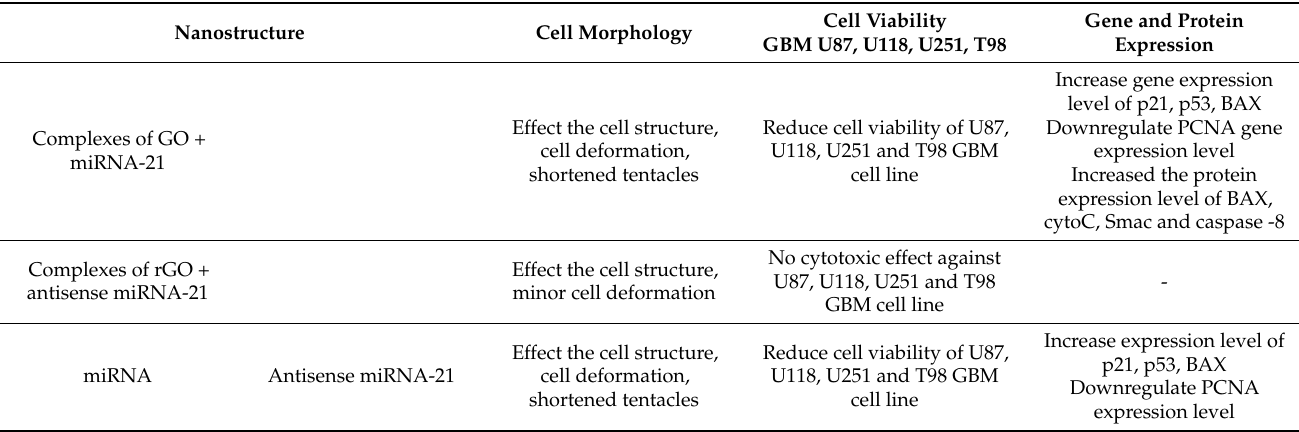
Table 3. Summary